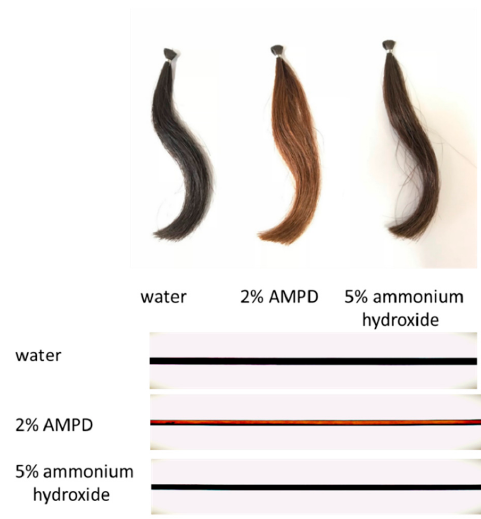
Figure 2. Images of human hair bleached with H 2 O 2 and 2% AMPD aqueous solution and human hair bleached with H 2 O 2 and 5% ammonium hydroxide. The experimental conditions are described in Section 2.2. ( Above ) Images taken with a digital camera of same person’s hairs; ( Below ) images taken with an optical microscope. Top: human hair bundle immersed in pure water (control); middle: human hair bundle bleached with H 2 O 2 and AMPD aqueous solution; bottom: human hair bundle bleached with H 2 O 2 and ammonium